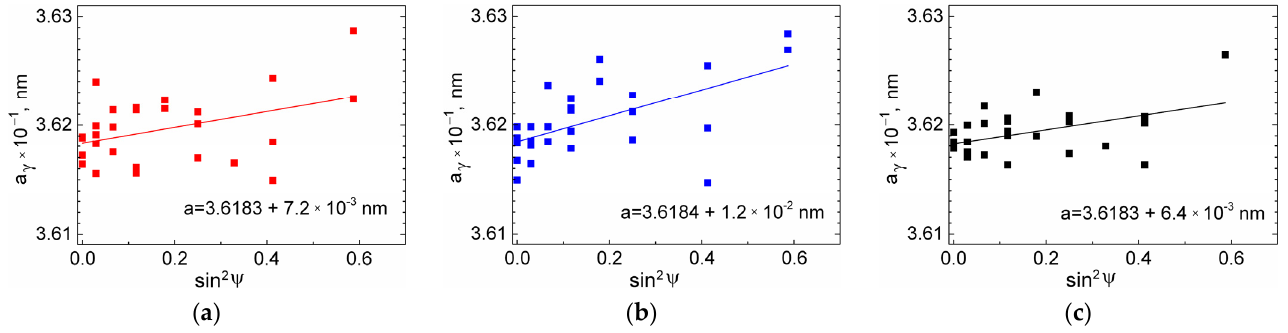
Figure 7. The a γ austenite lattice parameter vs. the sin 2 ψ angle after the tensile tests: ( a ) at 293 K, ( b ) at 253 K, and ( c ) 77 K. Pearson’s correlation coefficient (r) was 0.403, 0.59, and 0.47 for test temperatures of